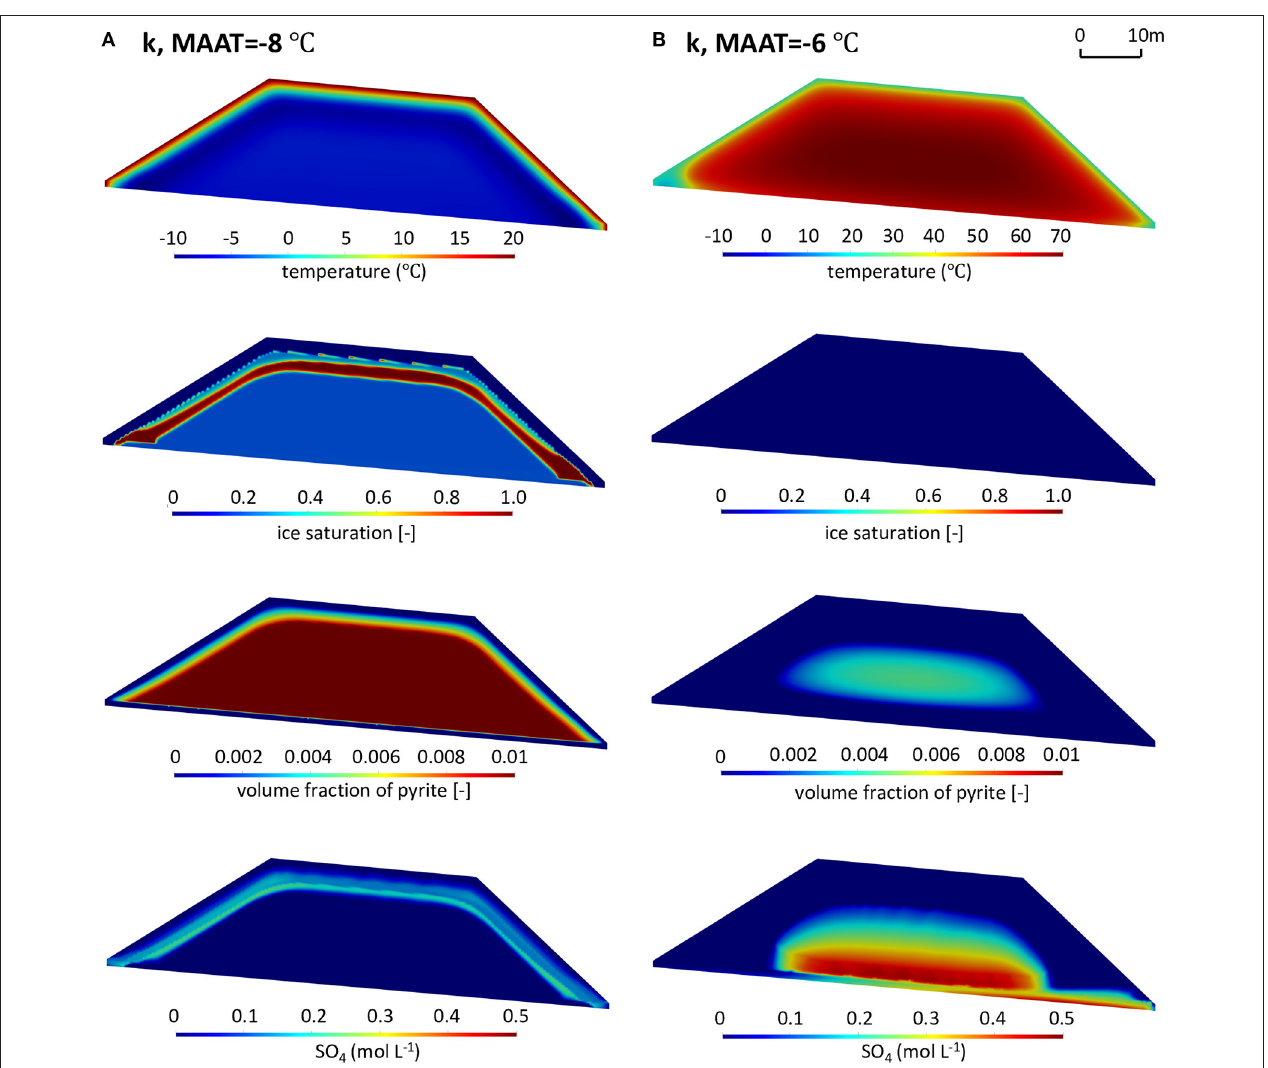
FIGURE 9 | Contours of temperature (T), ice saturation (S ice ), residual volume fractions of pyrite ( ϕ pyrite ), and sulfate concentrations (SO 4 ) in the waste rock pile in the summer of the 50th year for scenarios with reference pyrite reactivity ( k refers to k ref FeS − 6 ◦ C.